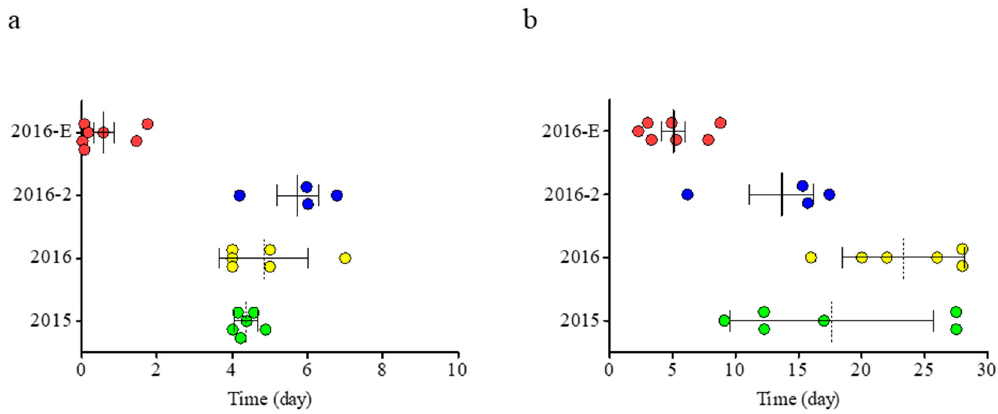
Figure 5. Summary of ( a ) lag time and ( b ) startup time for all experiments in this work, i.e., 2015, 2016, 2016 ‐ S, 2016 ‐ 2, and 2016 ‐ E.